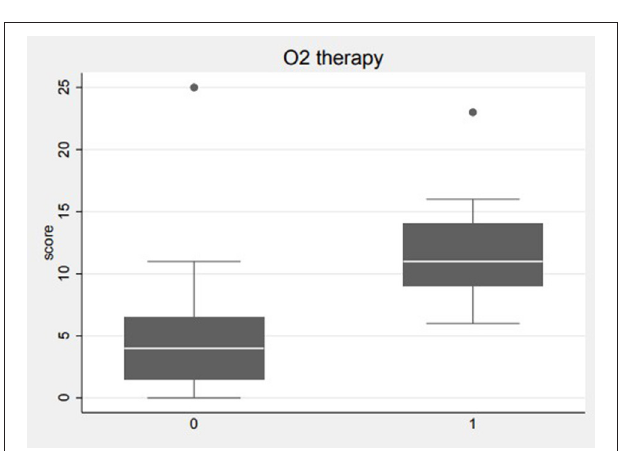
FIGURE 2 | Correlation between LUS score and oxygen therapy. The average LUS score in patients requiring oxygen therapy is equal to 12.